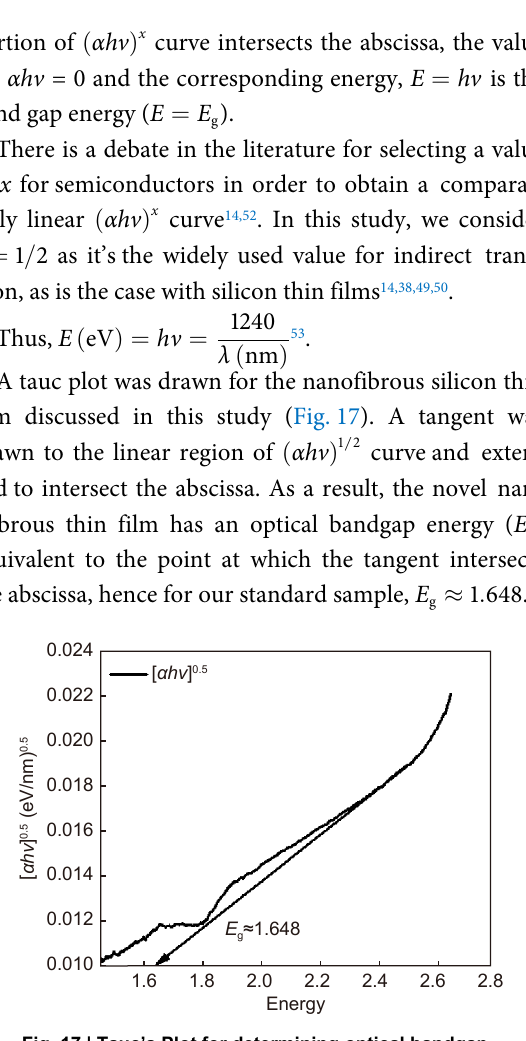
Fig. 17 | Tauc’s Plot for determining optical